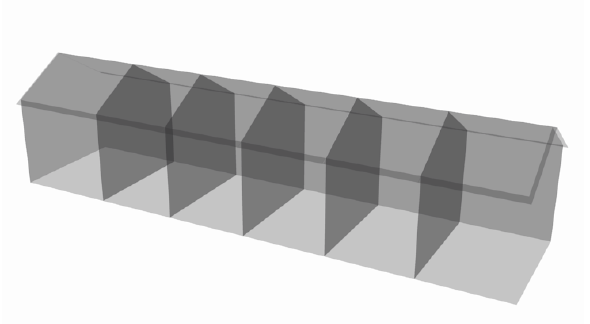
Figure 3: Aggregation of Buildings and AbstractBuilding (case of terraced